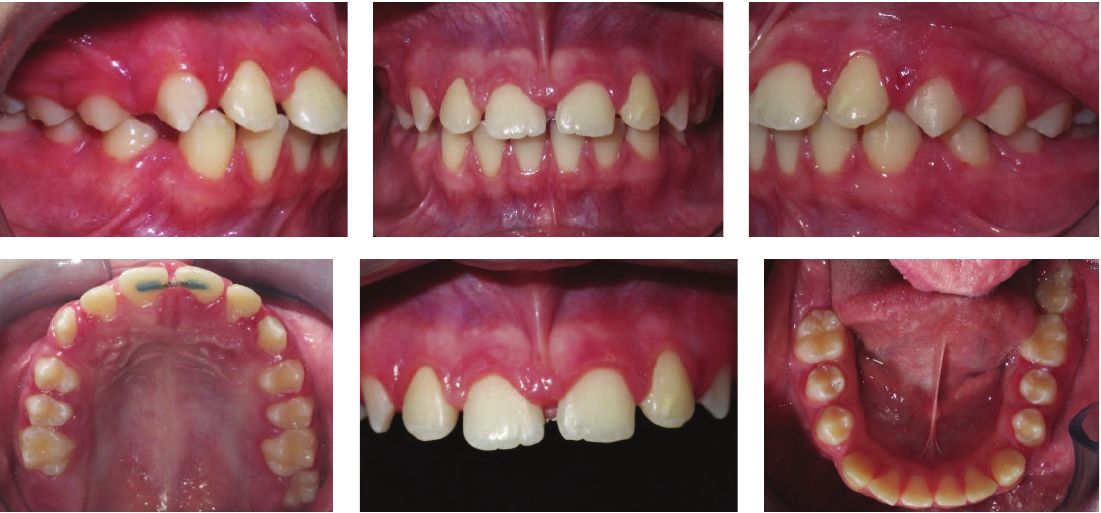
Figure 4: Posttreatment intraoral photographs.